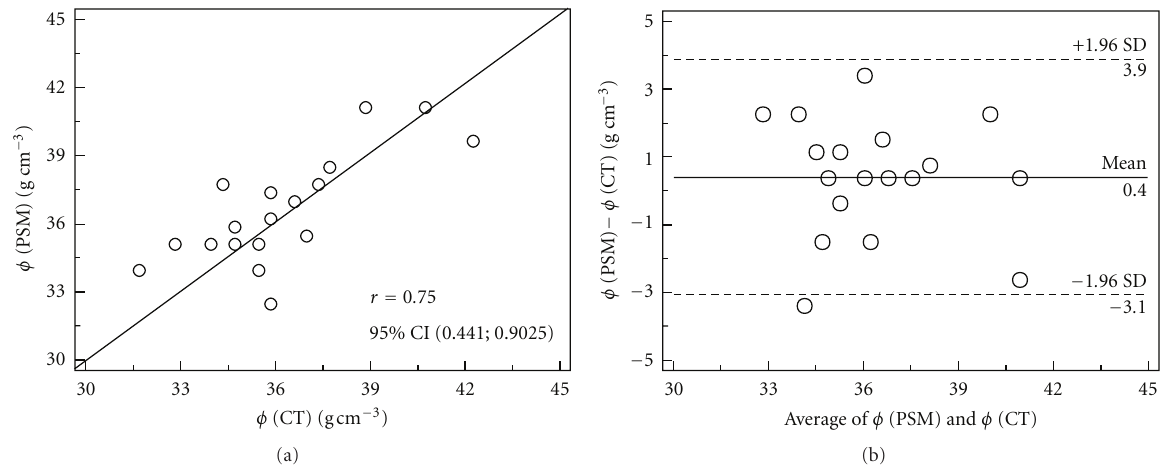
Figure 5: (a) Soil porosity ( φ ) measured by the computed tomography (CT) and para ffi n-sealed methods (PSMs), with line of equality; (b) Bland-Altman plot.